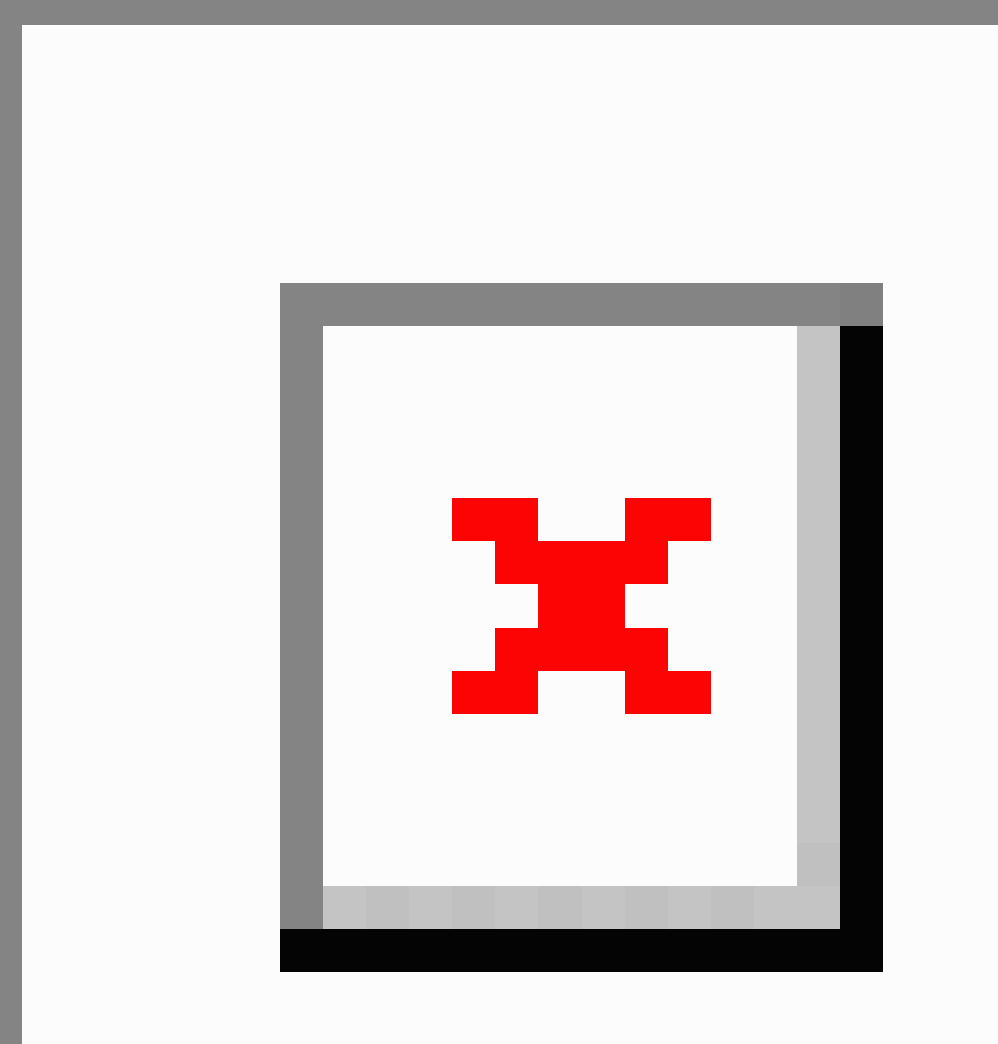
Figure 1. CONSORT flow